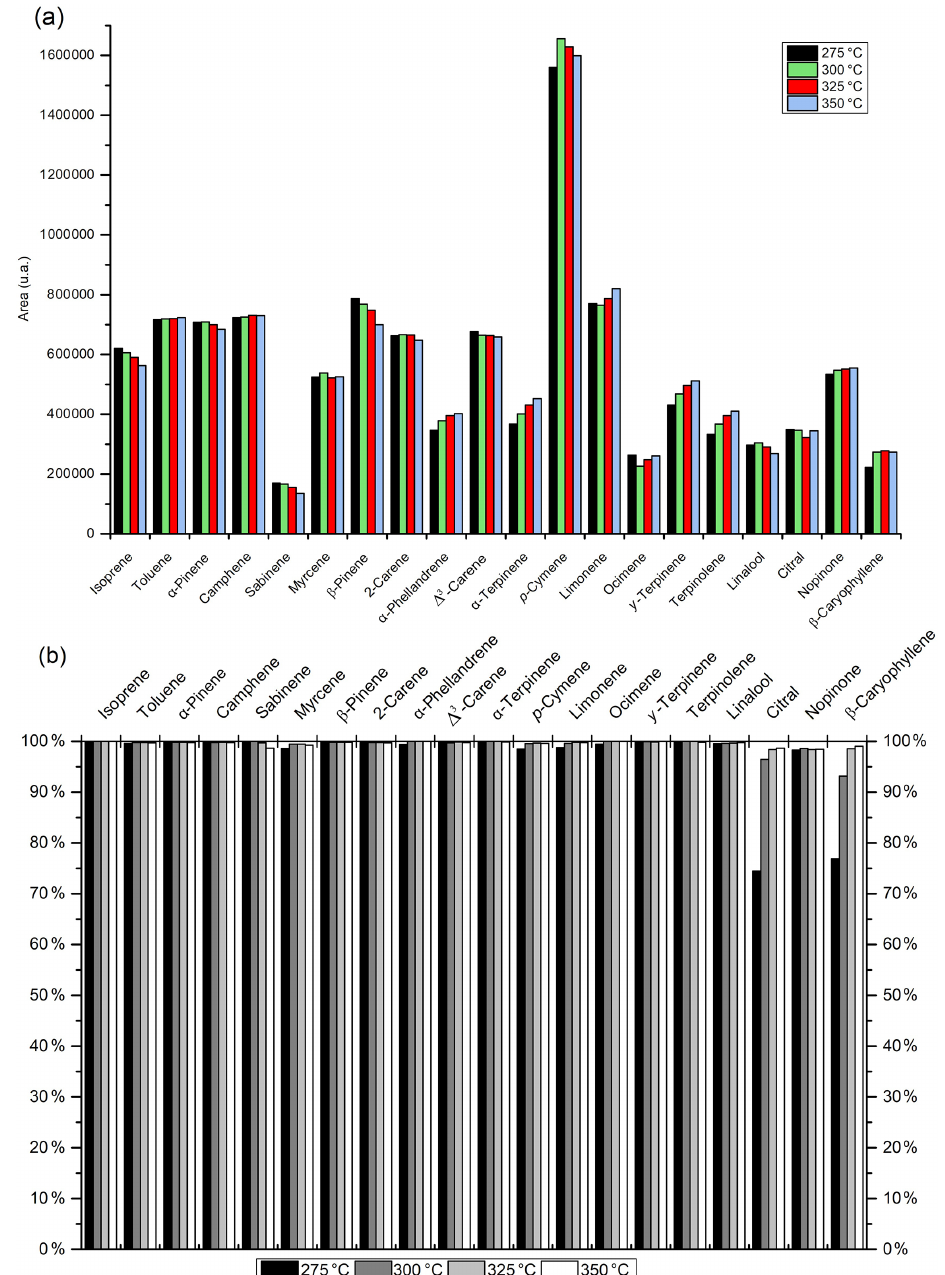
Figure 3. Investigation of the optimal desorption temperature for BVOC measurements. Two replicates performed at each temperature: (a) peak areas observed after the first desorption analysis and (b) the desorption